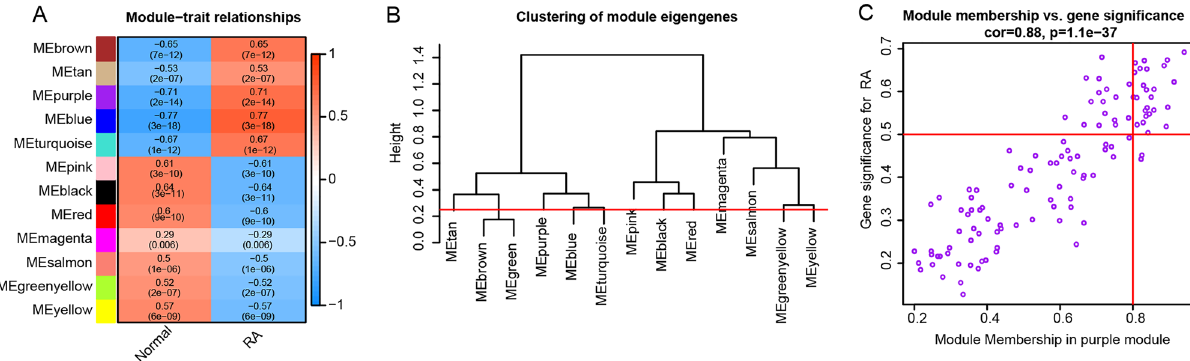
Figure 3. WGCNA modules analysis. ( A ) Heatmap of the WGCNA module correlations with RA and normal clinical traits. ( B ) Cluster dendrogram of the module eigengenes. The dissimilarity of module eigengenes is calculated to merge some similar modules with a height cut-off value of 0.25. ( C ) Scatter plot of the gene significance for the RA vs. the module membership in the purple